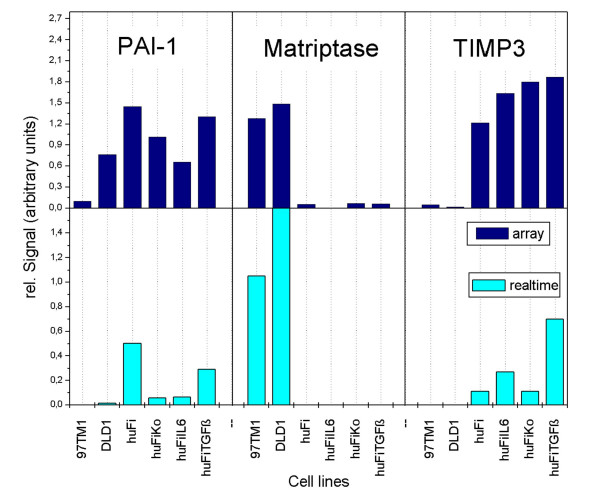
Comparison of template specific hybridization pattern with QRT- PCR data. Signal intensities for matriptase, TIMP3 and PAI-1 were normalized to the ß-actin signal. Upper part: array data; lower part: QRT- PCR data. Cell lines: 97TM1, DLD-1, huFi (established line of human fibroblasts), primary synovial human fibroblasts either treated with IL-6 (huFiIL6) and TGFβ (huFiTGFß), respectively, for 24 h in FCS free medium, or non treated (huFiKo). Samples for the array experiments were labelled according to the linear amplification protocol with target specific primers. Amplifications in real time experiments were performed with gene specific primers (primer sequences: matriptase left primer: 5'-gat cct gca aaa ggg tga ga-3', right primer: 5'-cac ttt gga ggc tga gga ag-3'; TIMP3 left primer: 5'-ctt ctg caa ctc cga cat cg-3', right primer 5'-gta gtg ttt gga ctg gta gc-3'; PAI-1 left primer: 5'-gat cga ggt gaa cga gag t-3', right primer: 5'-cac agt gga ctc tga gat g-3').